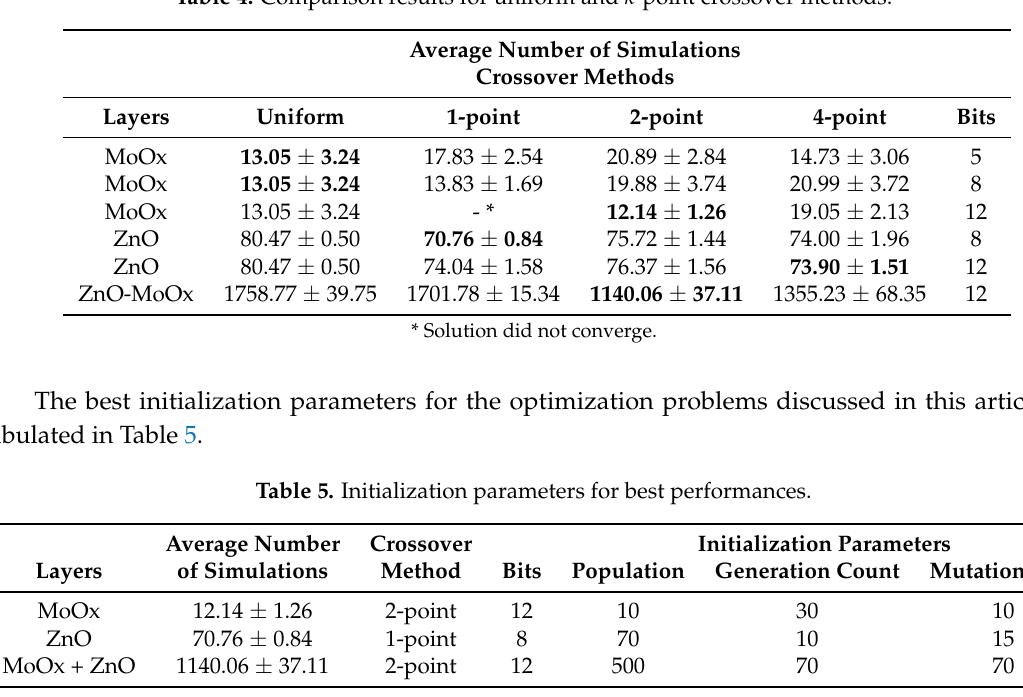
Table 4. Comparison results for uniform and k -point crossover methods.